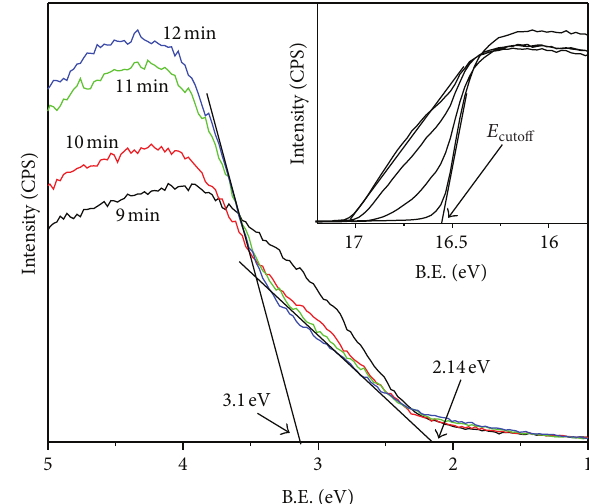
F 3: Transmittance spectra of the ITO, ITO/ZnO, and ITO/ �lms. F 4: UPS pro�ling spectra of ITO/CdS SnO 2